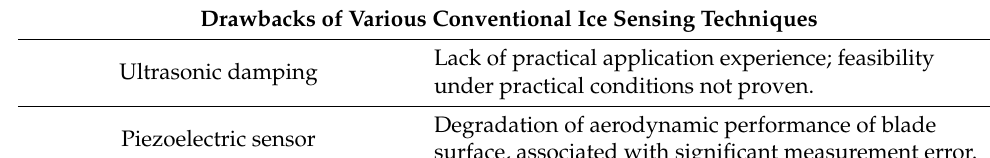
Table 1. Summary of the main disadvantages of the different ice sensing techniques.